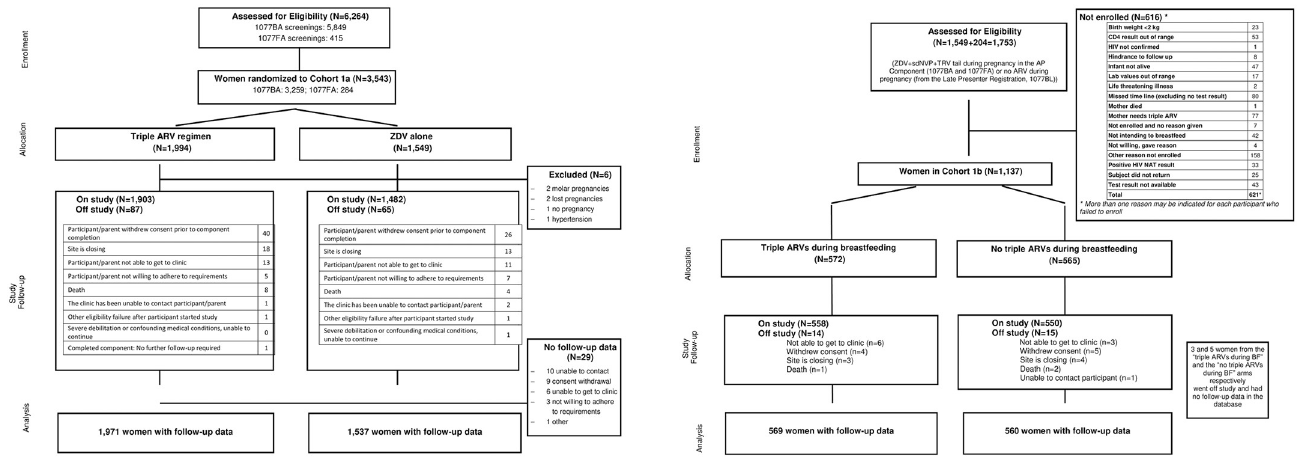
Fig 2. A. CONSORT diagram for the AP-only analysis group Fig 2B CONSORT diagram for the PP-only analysis